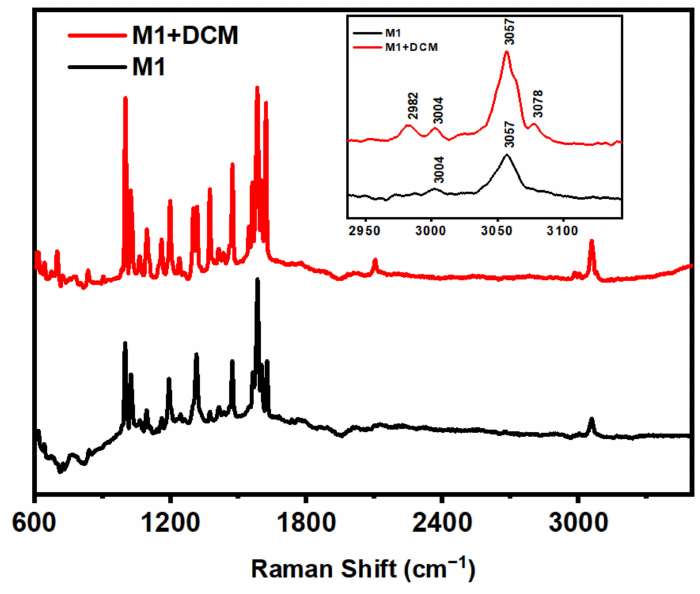
Figure 8. Raman spectra for solid M1 before and after DCM treatment (inset: enlarged view of several peaks).